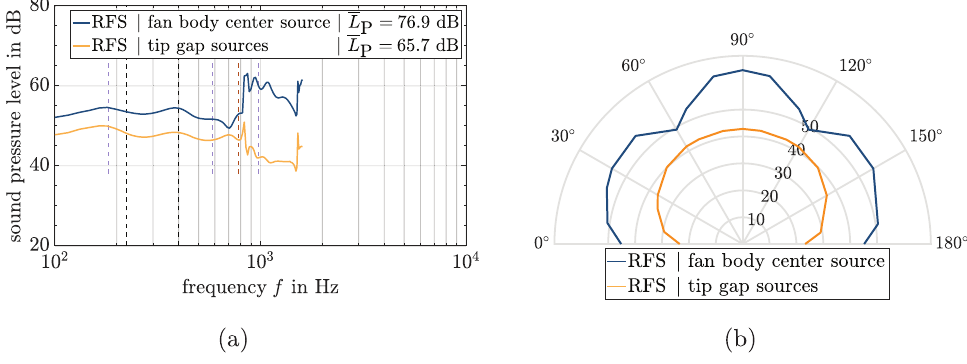
Figure 10. Pre-characterization simulations of geometry. (a) Transmission loss due to cross section changes; highlighted k /4- and k / 2-resonance frequencies. (b) Overall simulated sound pressure of the MPA setup without MPP point at the nozzle (cf. Fig. 6c); indicated cut-off frequencies f c,RFS and f c,MFS .